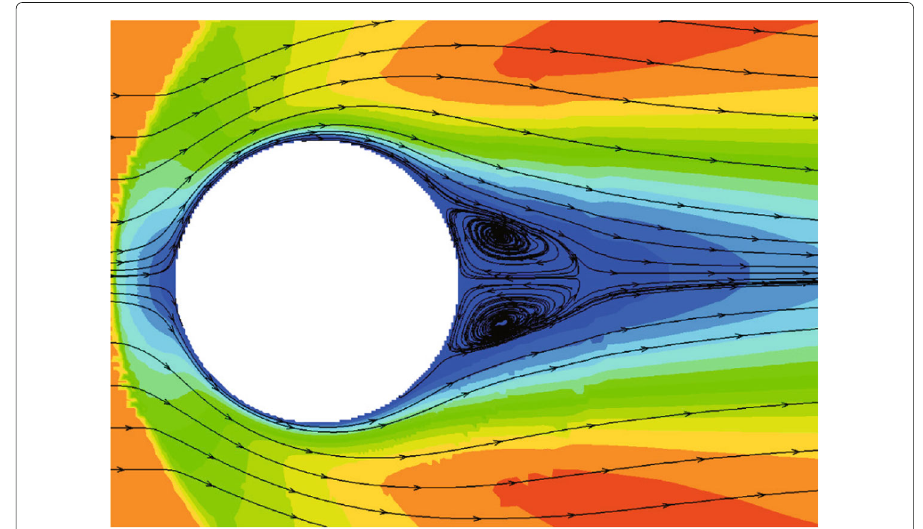
Fig. 27 Streamlines and Mach number contours for supersonic flow around a sphere ( Z = 0